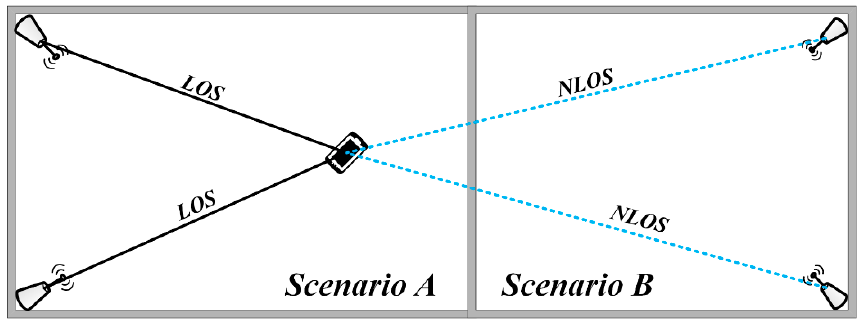
Figure 3. The examples of Scenario, LOS, and NLOS.